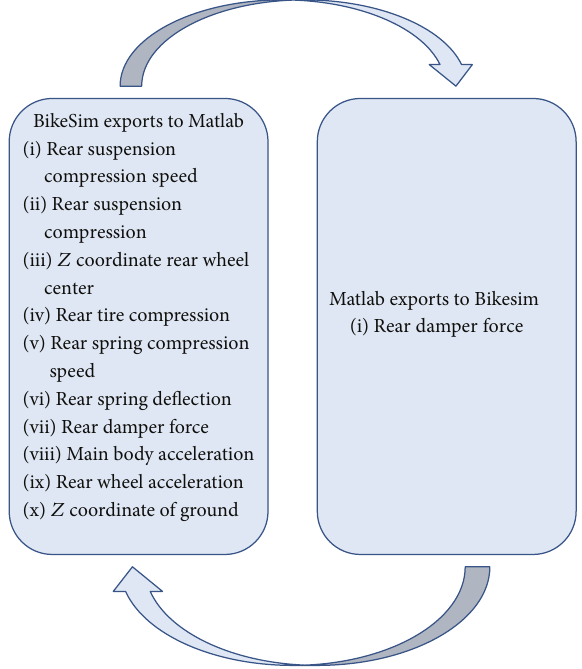
Figure 2: BikeSim and Matlab communication